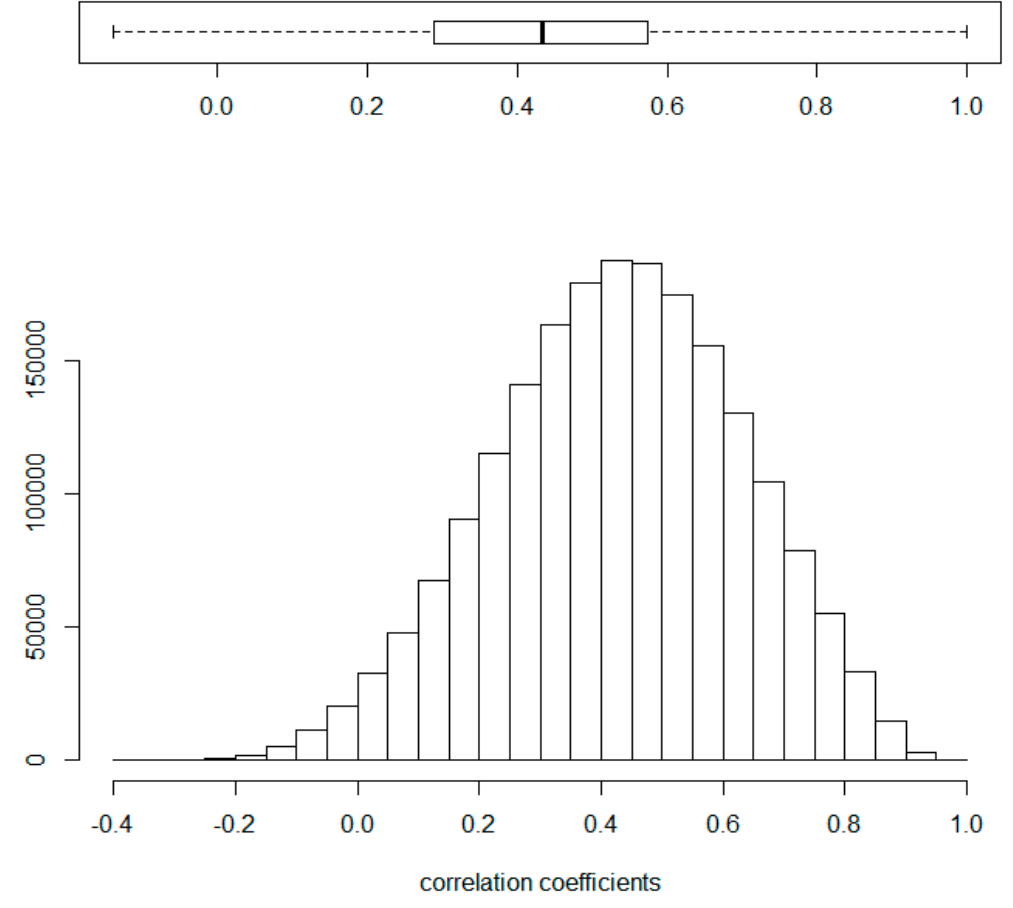
Table 3. Classification performance of the proposed selection method with SIS-LASSO, SIS-